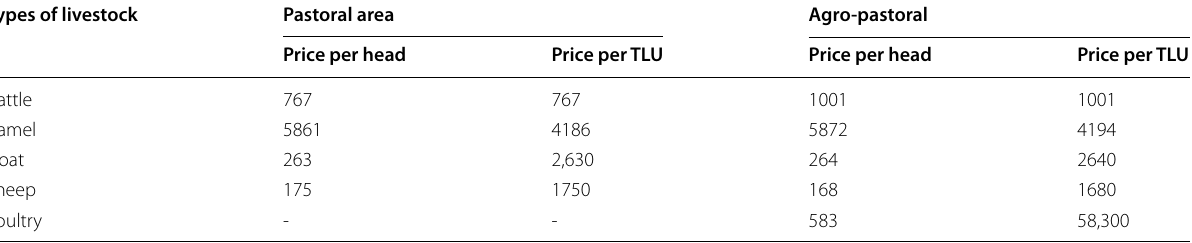
Table 1 Livestock price information in pastoral and agro-pastoral areas of Ethiopia